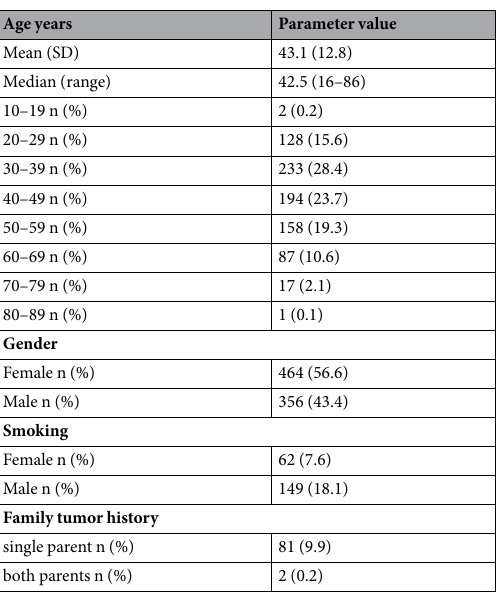
Table 1. Summary of characteristics of 821 non-cancer